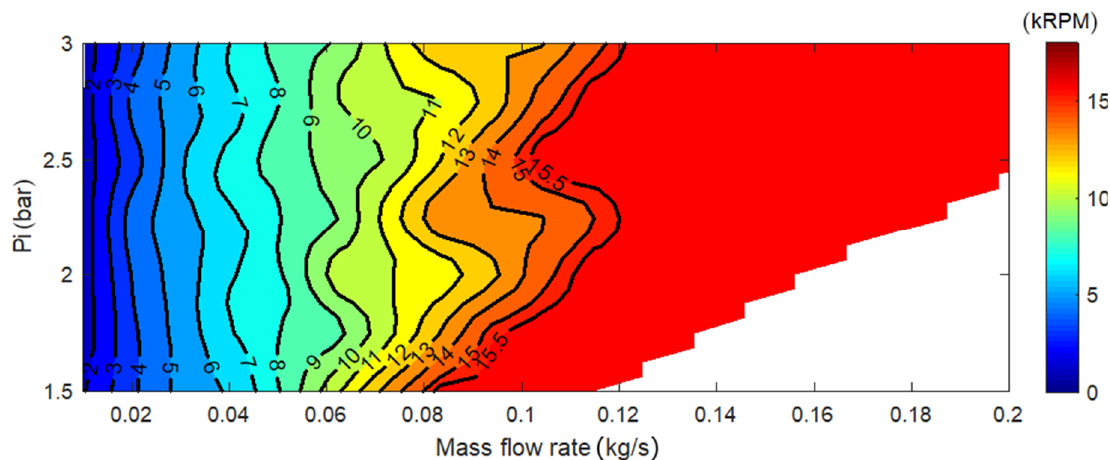
Figure 13. Rotational speeds corresponding to maximum isentropic efficiency of GL51 twin-screw expander running on air (Ti = 75 °C and Po = 1 bar).